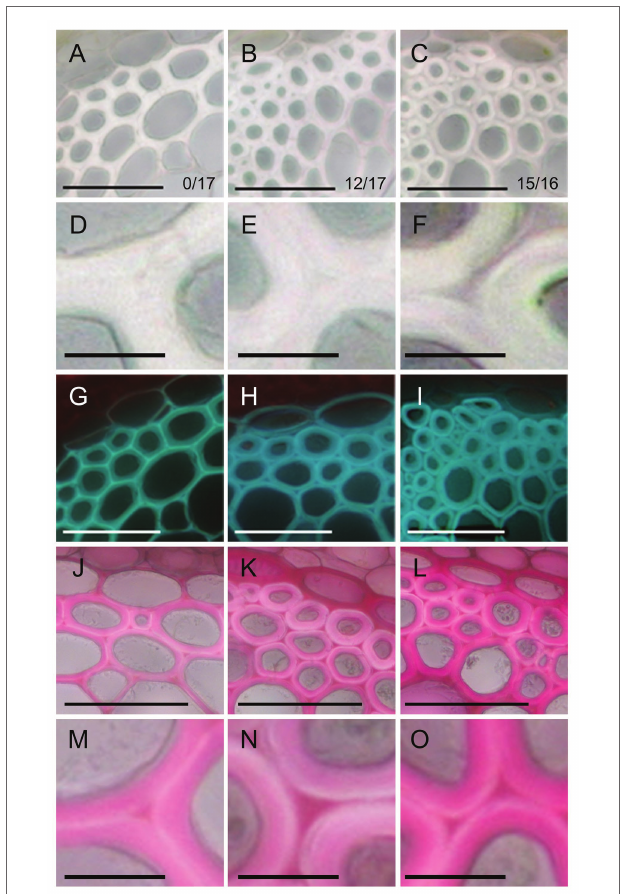
FIGURE 2 | Phenotype of fiber cells of inflorescence stems. Bright field images (A–F) , UV autofluorescence images (G–I) , and ruthenium red staining (J–O) of transverse sections of stems in the control (A,D,G,J,M) , ERF035- VP16 (B,E,H,K,N) , and ERF041-VP16 (C,F,I,L,O) lines. Numbers in (A–C) indicate the number of independent lines harboring an altered cell wall from the obtained T1 lines. Bars, 50 μ m (A–C,G–L) , 10 μ m (D–F,M–O) .